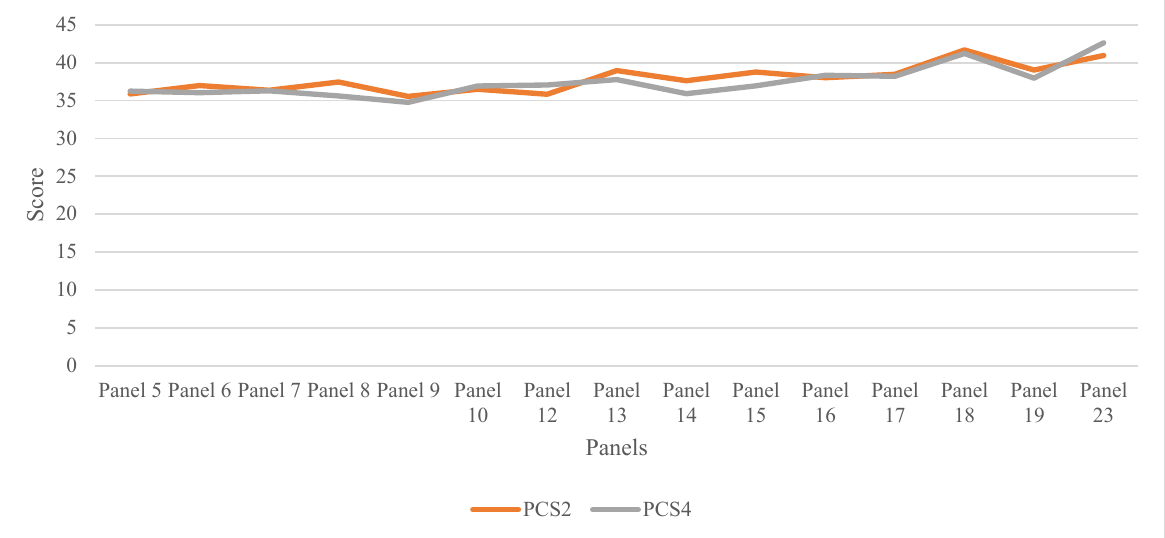
Figure 2. The trend of physical component score (PCS) domain, panels 5–23. Panels 11, 20, 21, and 22 are not shown in the graph due to an incomplete record of HRQOL. PCS2: physical component score in round 2, PCS4: physical component score in round 4.